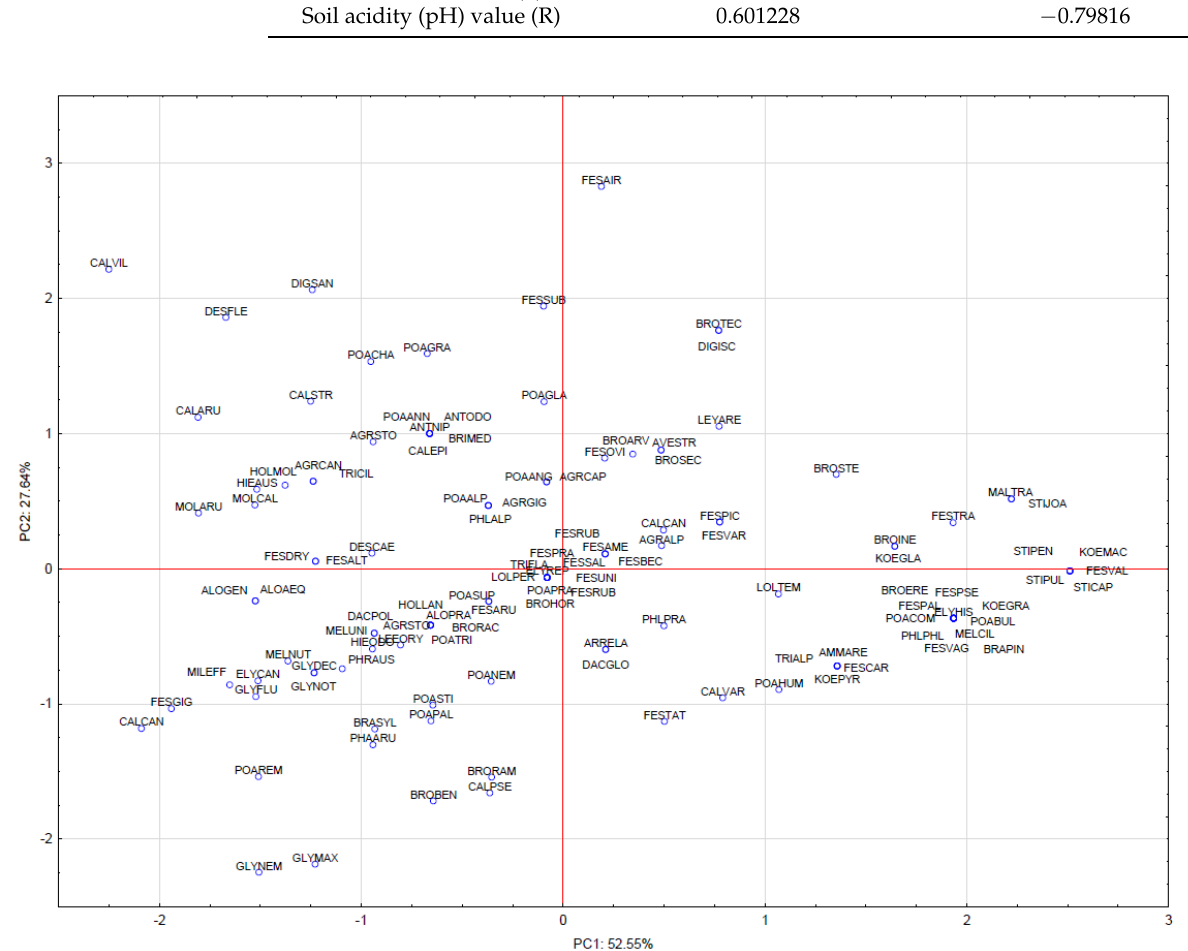
Figure 6. Principal components of analysis (PCA) of grasses according to the Ellenberg indicator values.